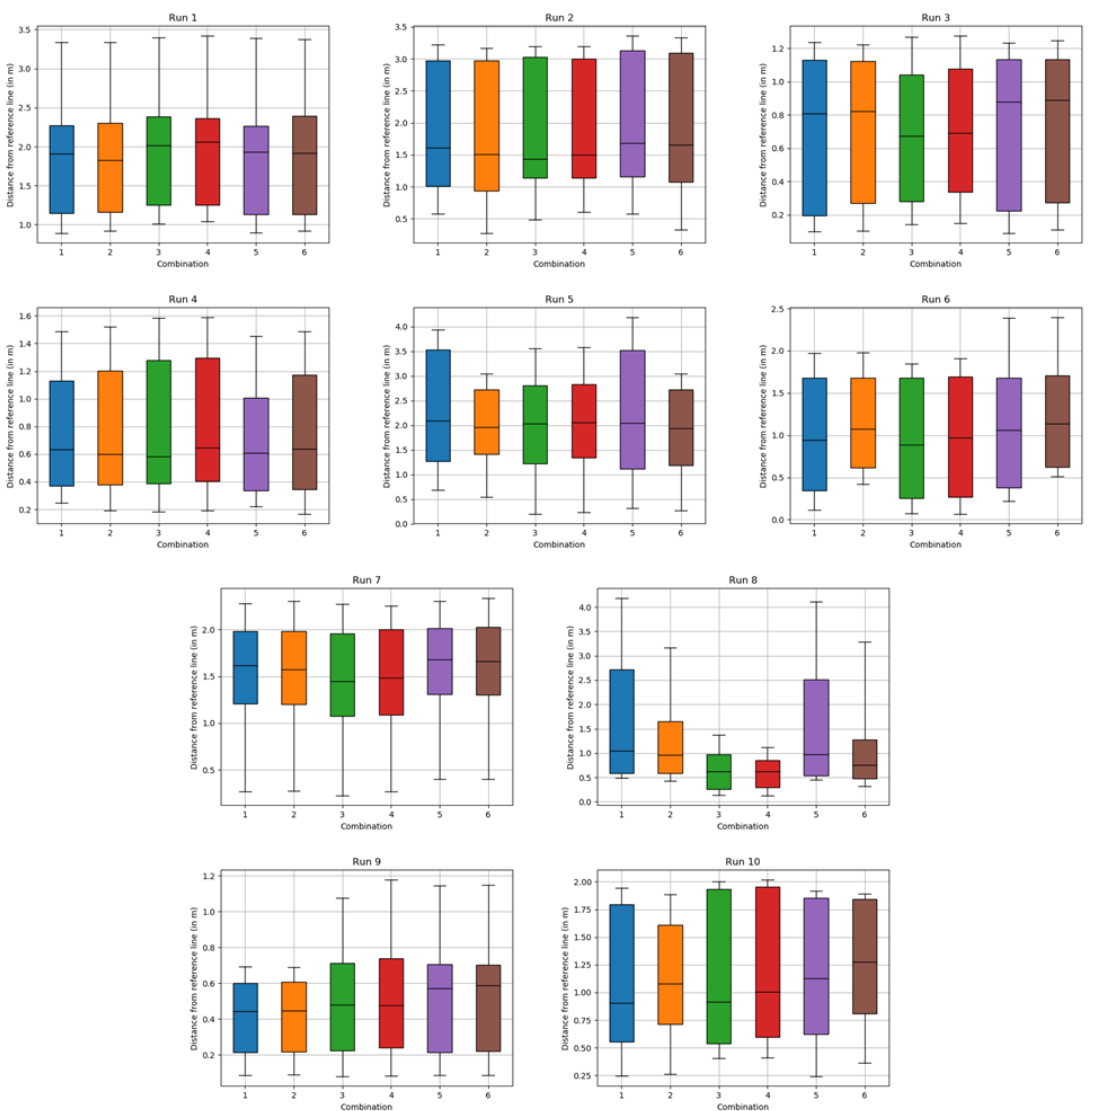
Figure A6. Boxplots of perpendicular distances of points falling in areas with no